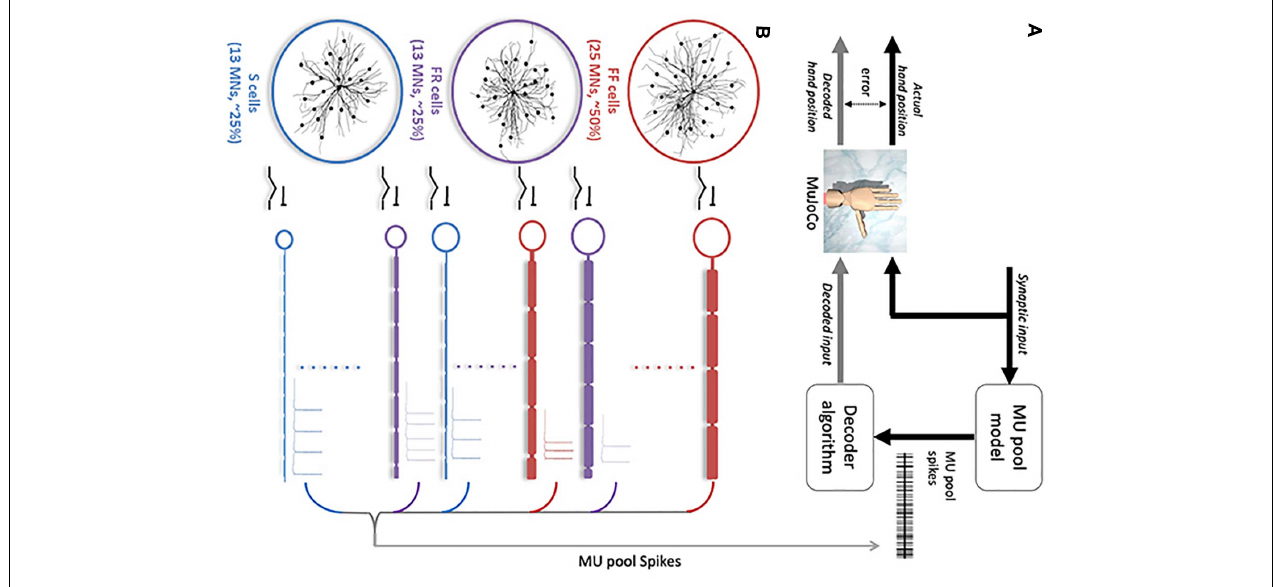
FIGURE 1 | Overview of decoder development and testing paradigm. (A) Block diagram illustrating the steps involved in the decoder development and testing. An excitatory synaptic input is simulated in the MU pool model (shown in B ), which generates action potentials in recruited MNs. Action potential spikes from individual MNs (MU pool spikes) serve as the input to the motor decoder. The decoder algorithm decodes the synaptic input and drives the MuJoCo prosthetic hand to move. The error between the decoded and actual hand position of the MuJoCo hand is calculated to assess the decoder performance. (B) Schematic diagram of the motor unit pool model published in Allen and Elbasiouny (2018) used to develop the decoder algorithm. The MU pool model consists of anatomically accurate, information of S- (blue), FR- (purple), and FF-MNs (red) with axon and soma sizes and 3D dendritic reconstructions, firing characteristics and type proportions as seen in the MG cat MN